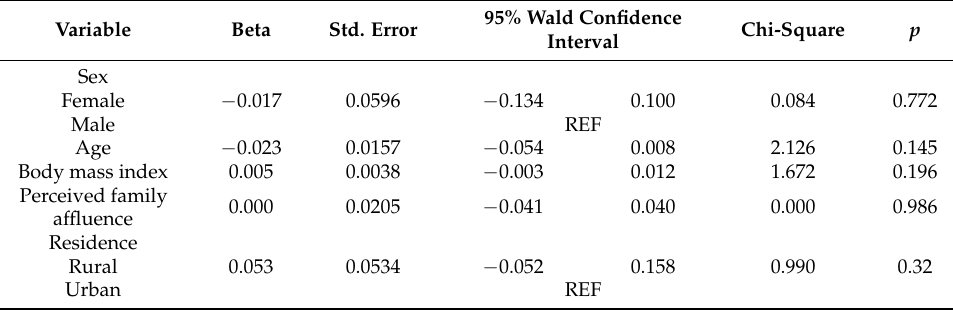
Table 4. Predictors of changes in light physical activity during the COVID-19 pandemic.